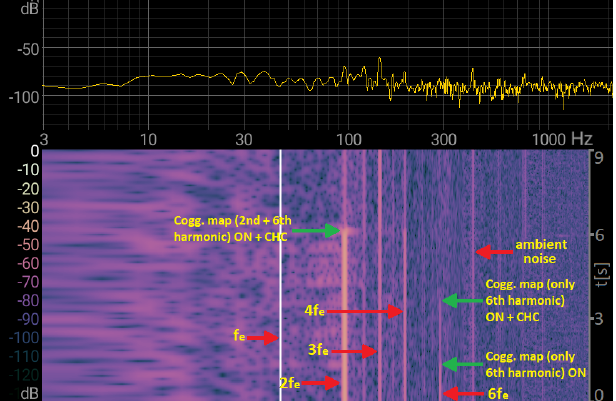
Figure 22. Sound FFT analysis at steady-state ω e = 300 rad algorithm. No-load condition.